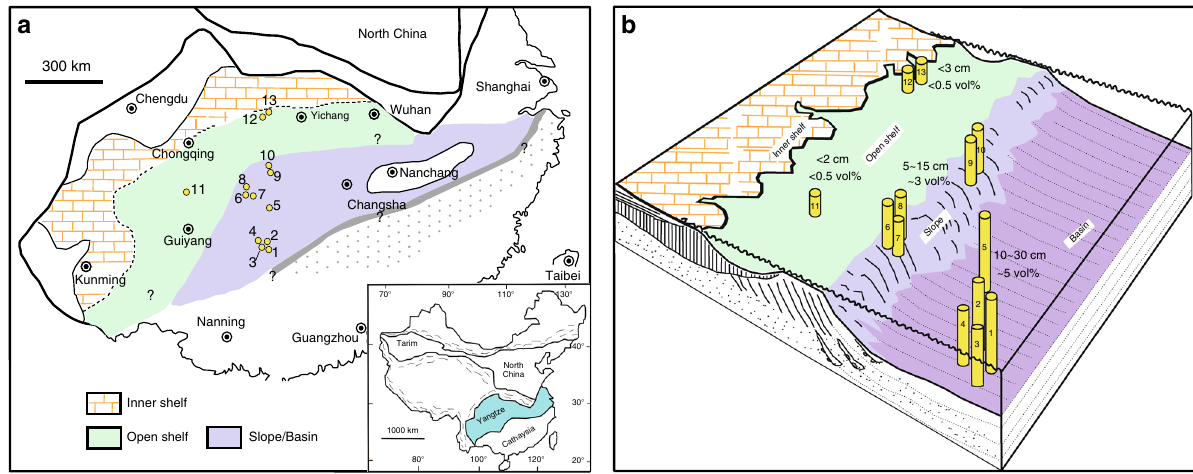
Fig. 1 Paleogeographic map and depositional model of the Yangtze Block. a Paleogeographic map, modi fi ed from Jiang et al. 21 showing the distribution of pyrite concretions in the topmost Nantuo Formation. Inset showing the geographic locality of the Yangtze Block. b Depositional model. The height of the columns indicates the maximum size of pyrite nodules observed in fi eld. 1: Yazhai, 2: Tongle, 3: Silikou, 4: Yangxi, 5: Yuanjia, 6: Huakoushan, 7: Bahuang,